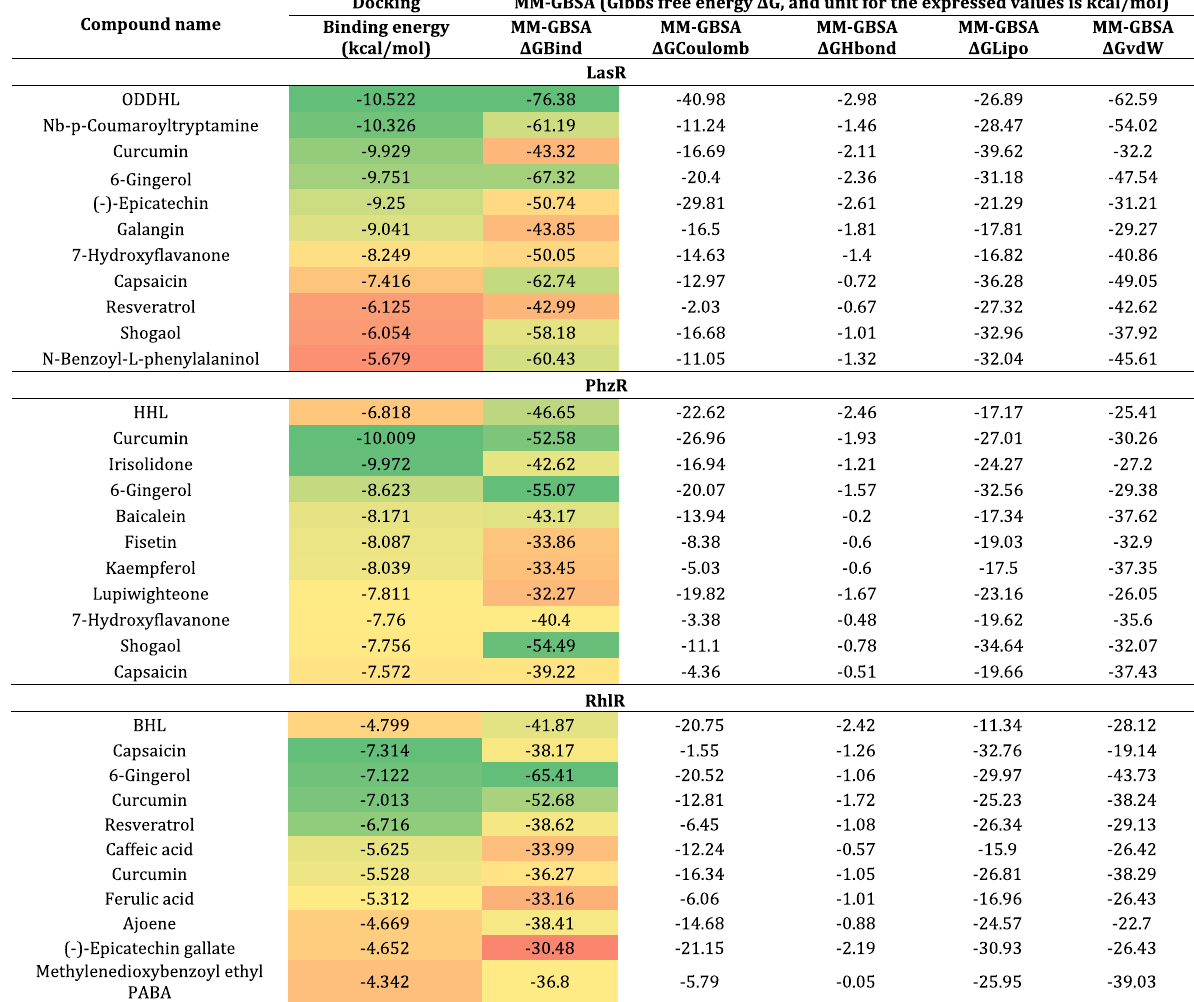
Table 3. Molecular docking and MM-GBSA energy profiles of native ligands and screened top hits during their interaction with LasR, PhzR and RhlR. ΔGBind = binding energy, ΔGCoulomb = Coulomb energy, ΔGHbond